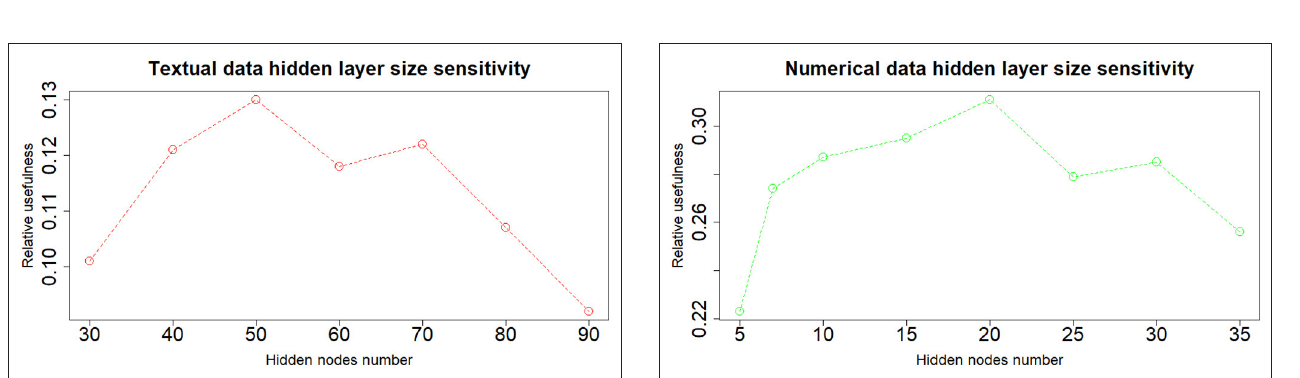
FIGURE 1 | Structure of the model.